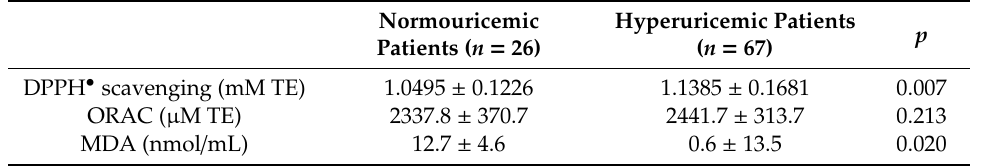
Table 2. Plasma antioxidant capacity and oxidant damage in normo and hyperuricemic patients on